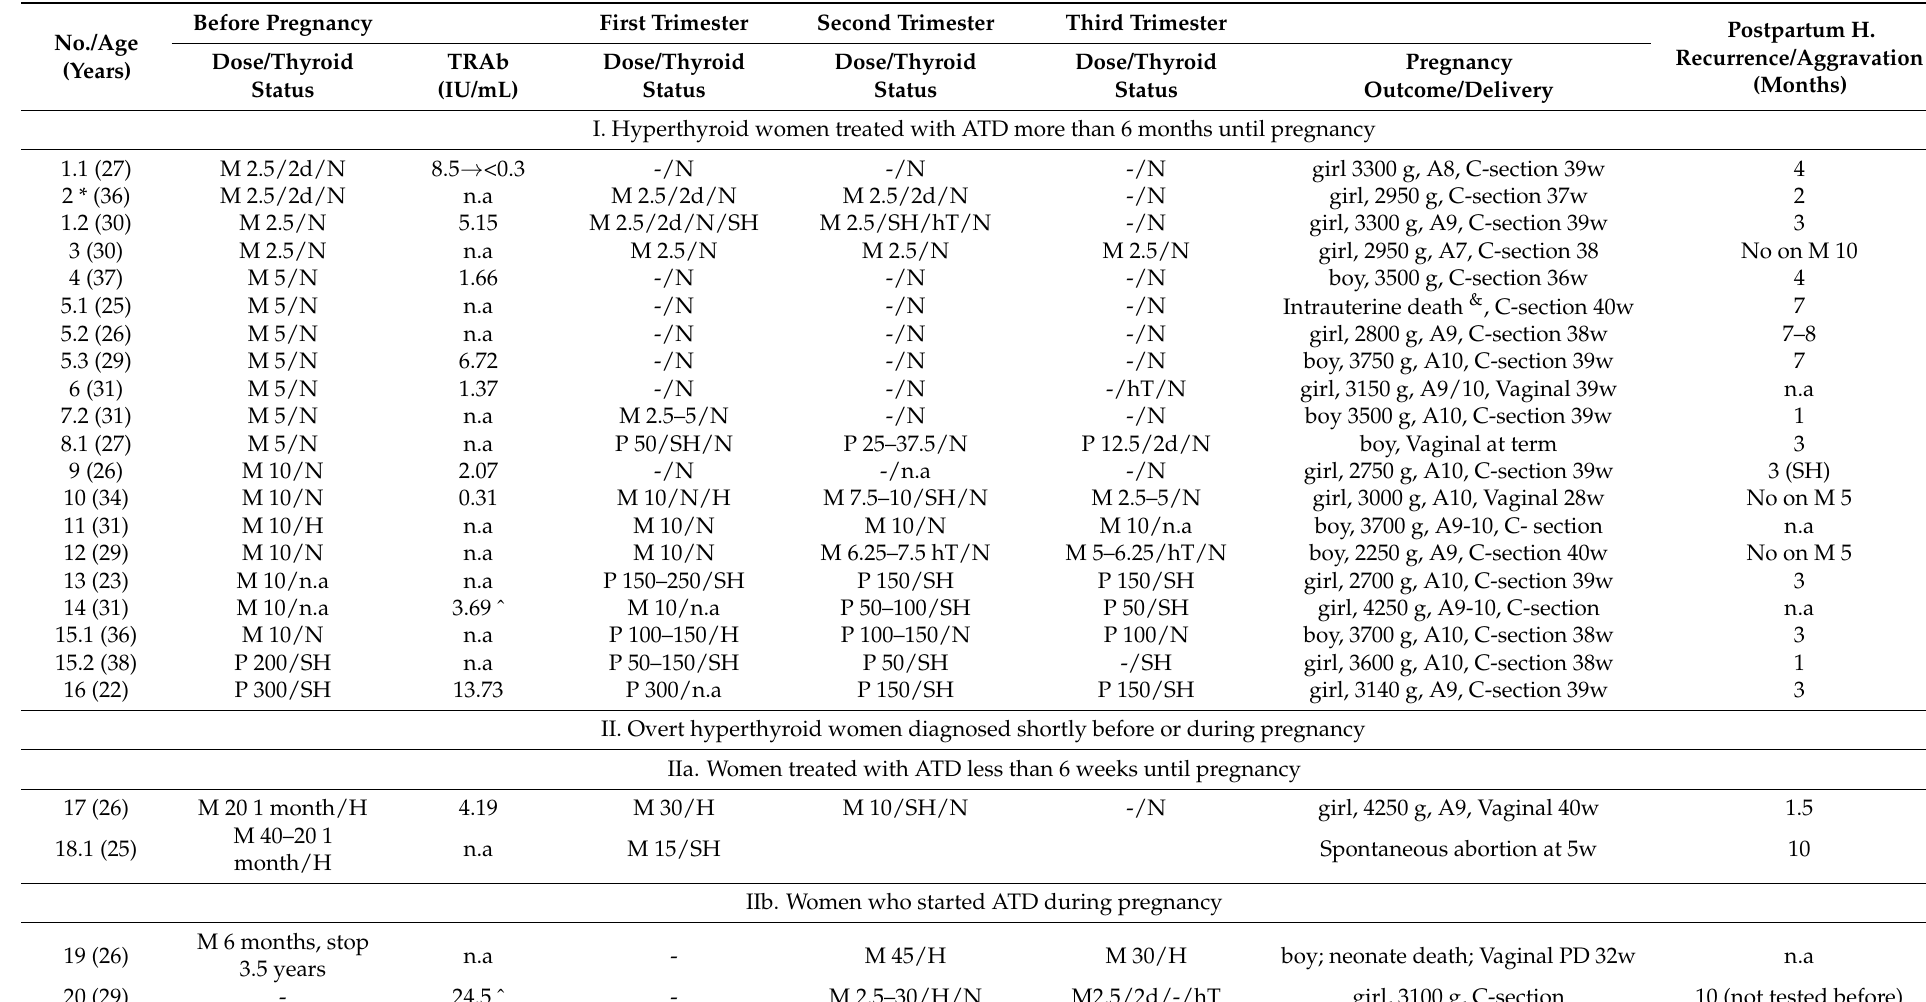
Table 2. Synopsis of women with hyperthyroidism, monitored during